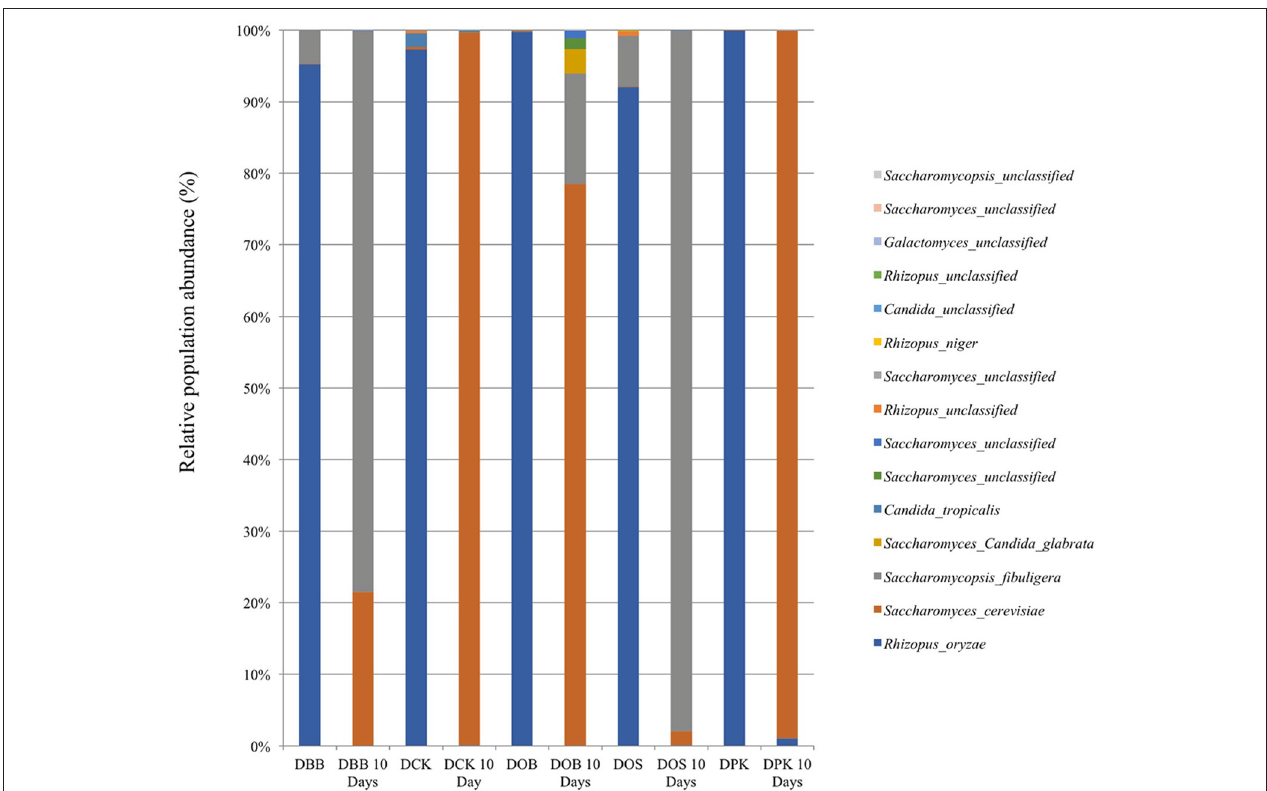
FIGURE 4 | Fungal composition (OTUs at the species level based on 26S amplicon sequencing) of the five starters and the corresponding microbial communities after 10 days of fermentation (labeled “10 Days”). DBB, DCK, DOB, DOS, and DPK are the five traditional Cambodian starters.